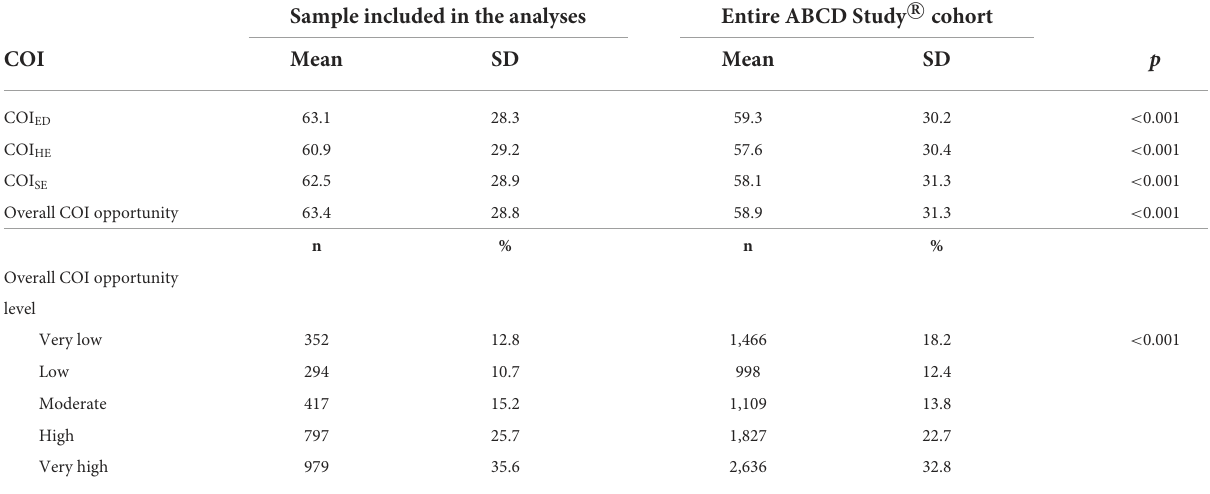
TABLE 2 Child opportunity index (COI)